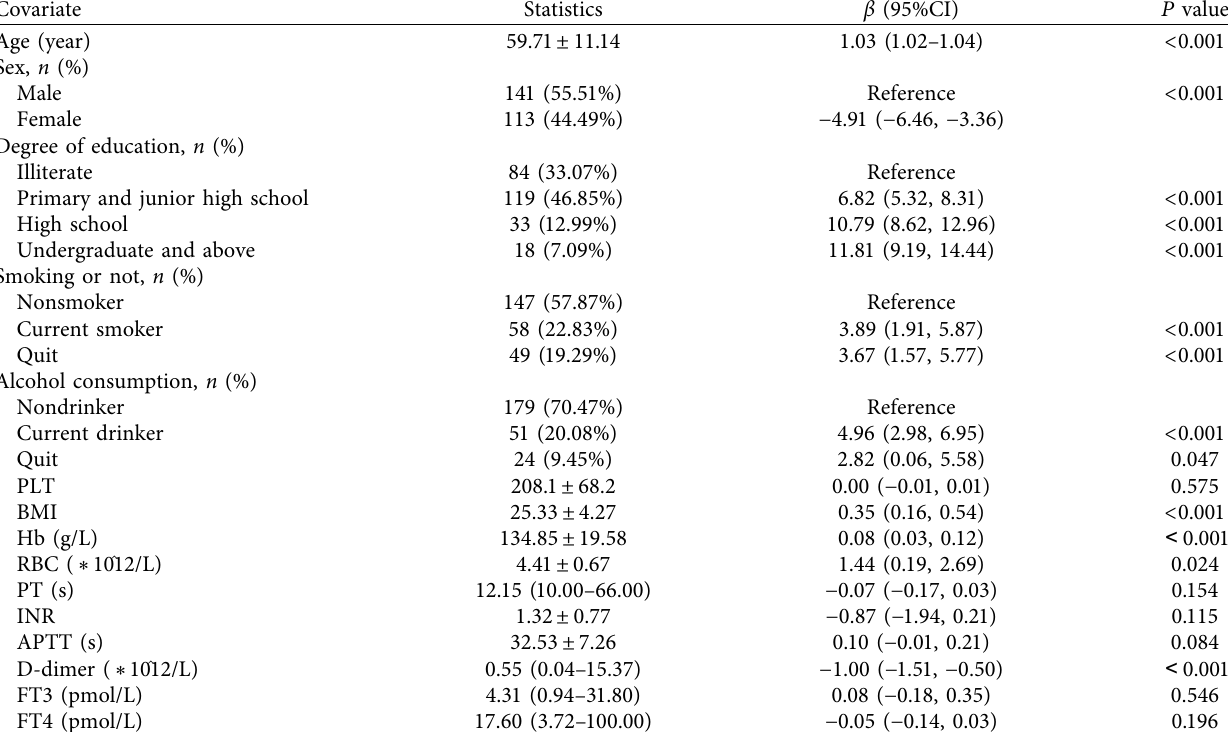
Table 2: Univariate analysis for cognitive function of atrial fibrillation